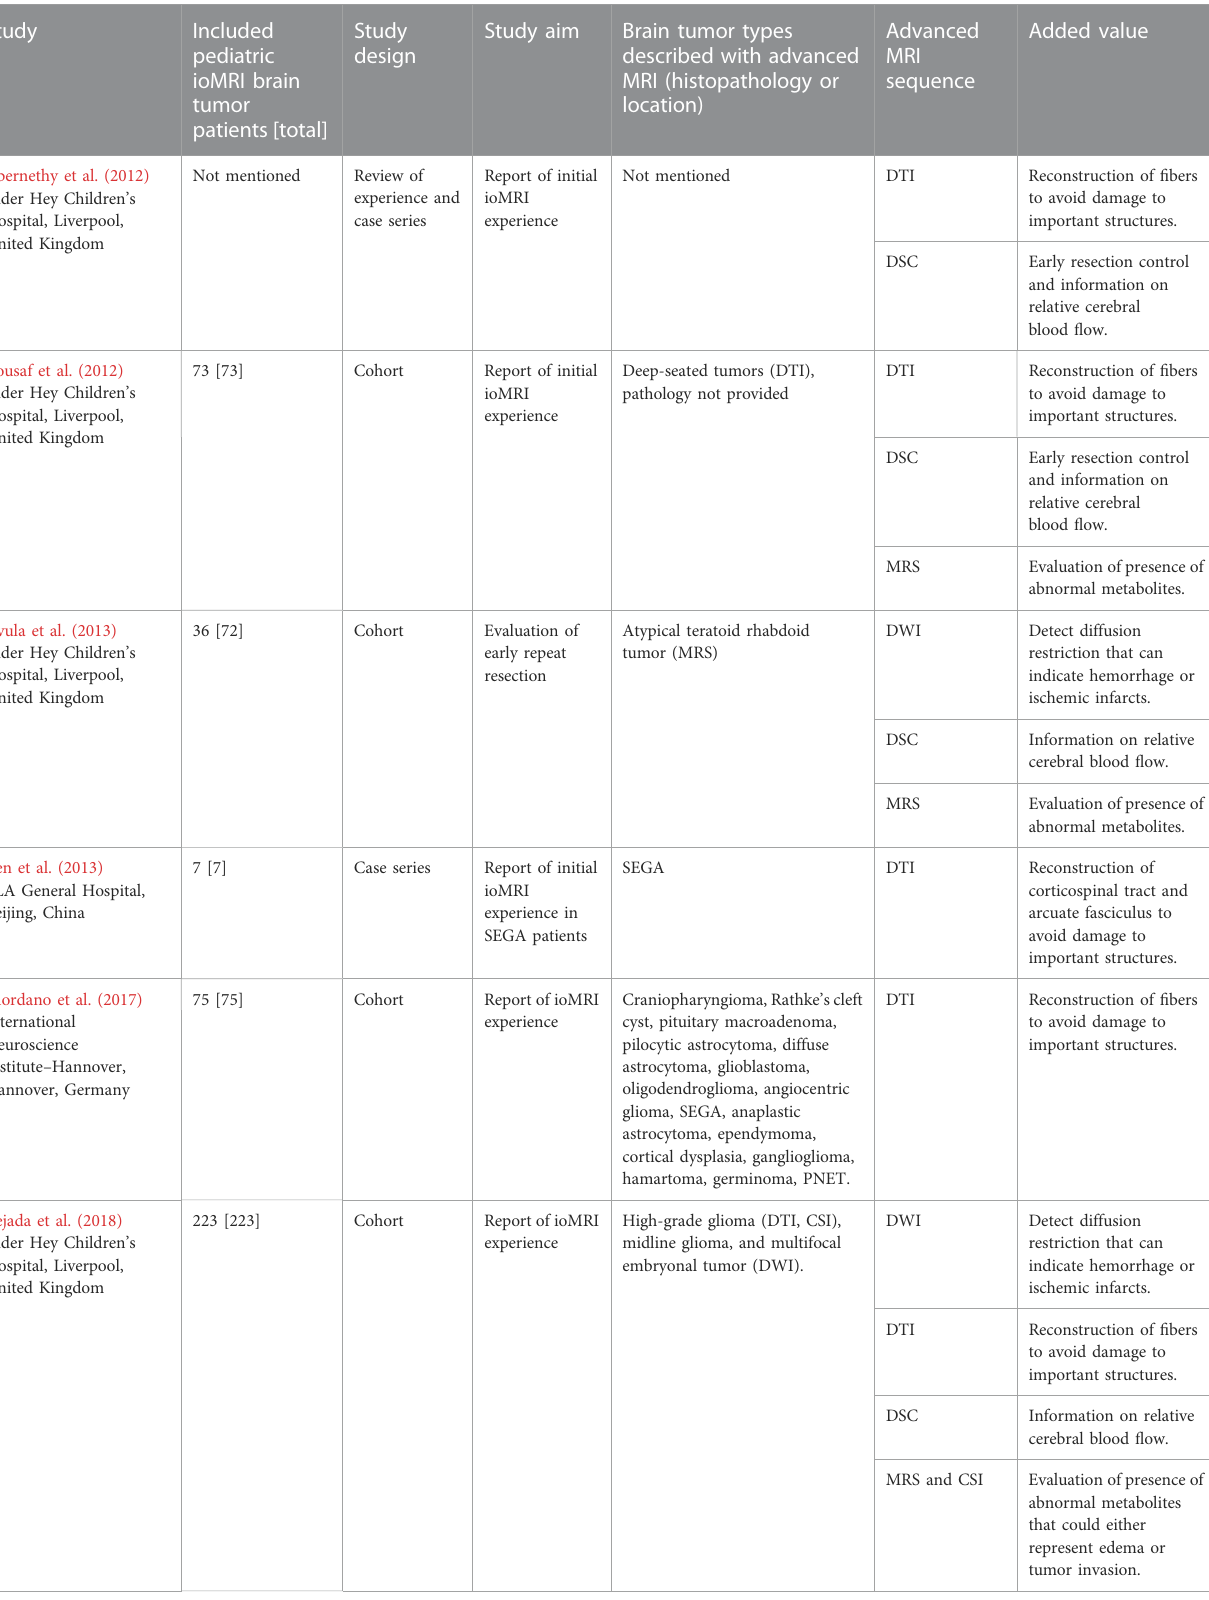
TABLE 1 Study designs and parameters of included